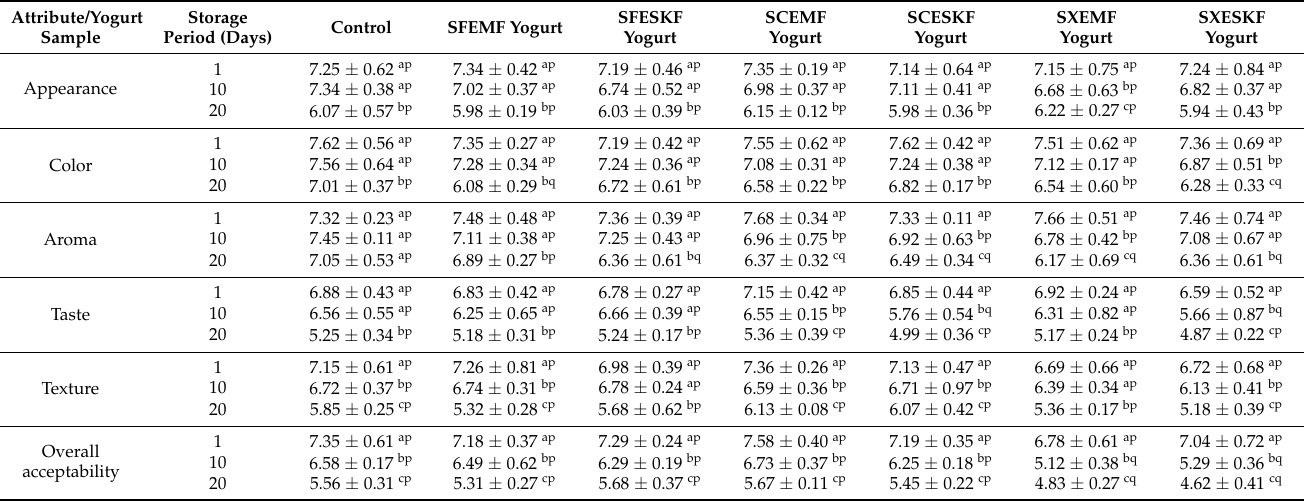
Table 4. Sensory attributes of functional liquid yogurt containing extracts from Majdool (MF) and Sukari (SKF) obtained using supercritical fluid (SFE), subcritical CO 2 (SCE) and Soxhlet (SXE) extrac- tion techniques during storage at 4 ◦ C for 20